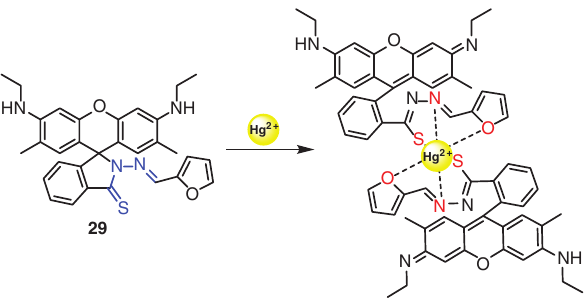
Figure 19: Recognition mechanism of probe 29 with Hg 2 +